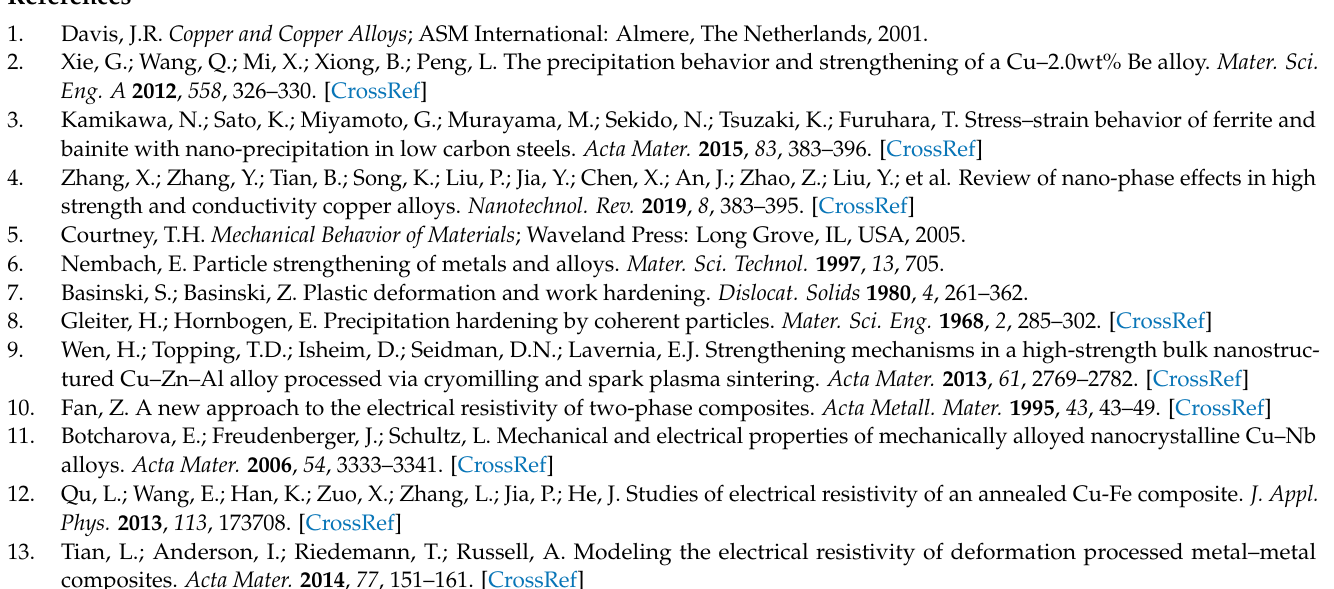
treatment. Figure S2: SEM images of Cu86.5 alloy after aging